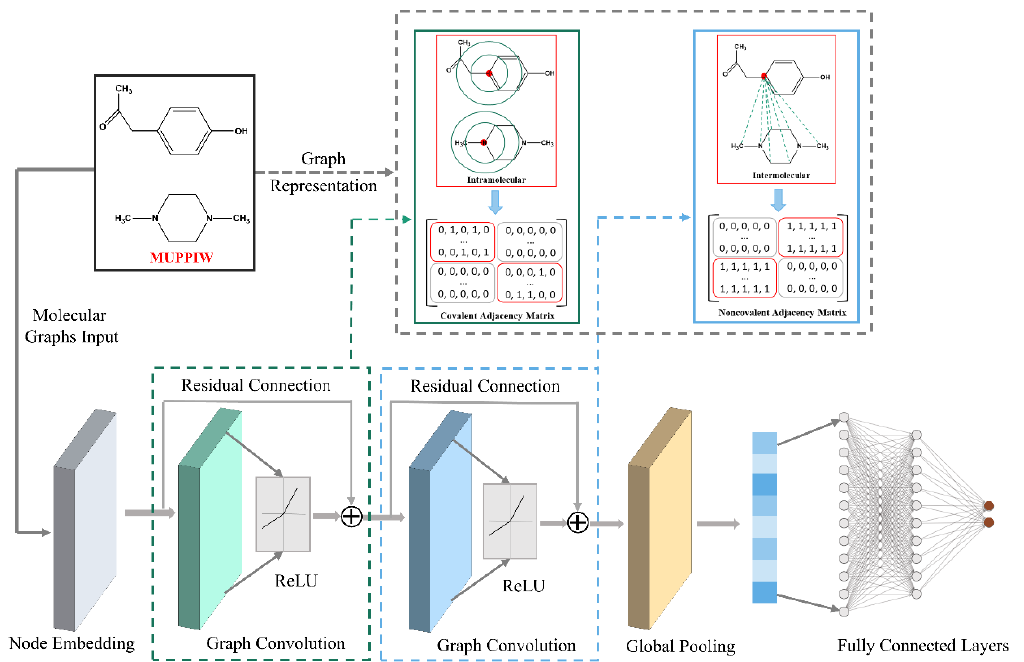
Figure 3. Illustration of CocrystalGCN architecture.